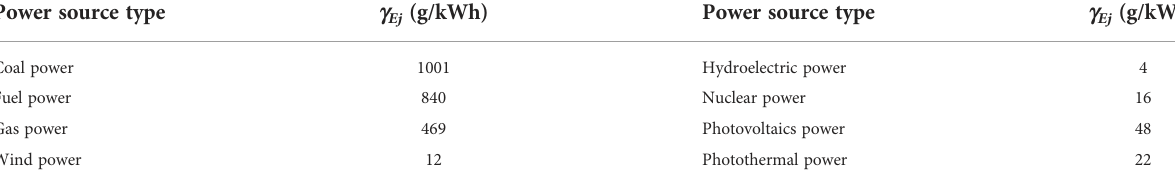
TABLE 1 Average carbon emission coef fi cient of each power source. Power source